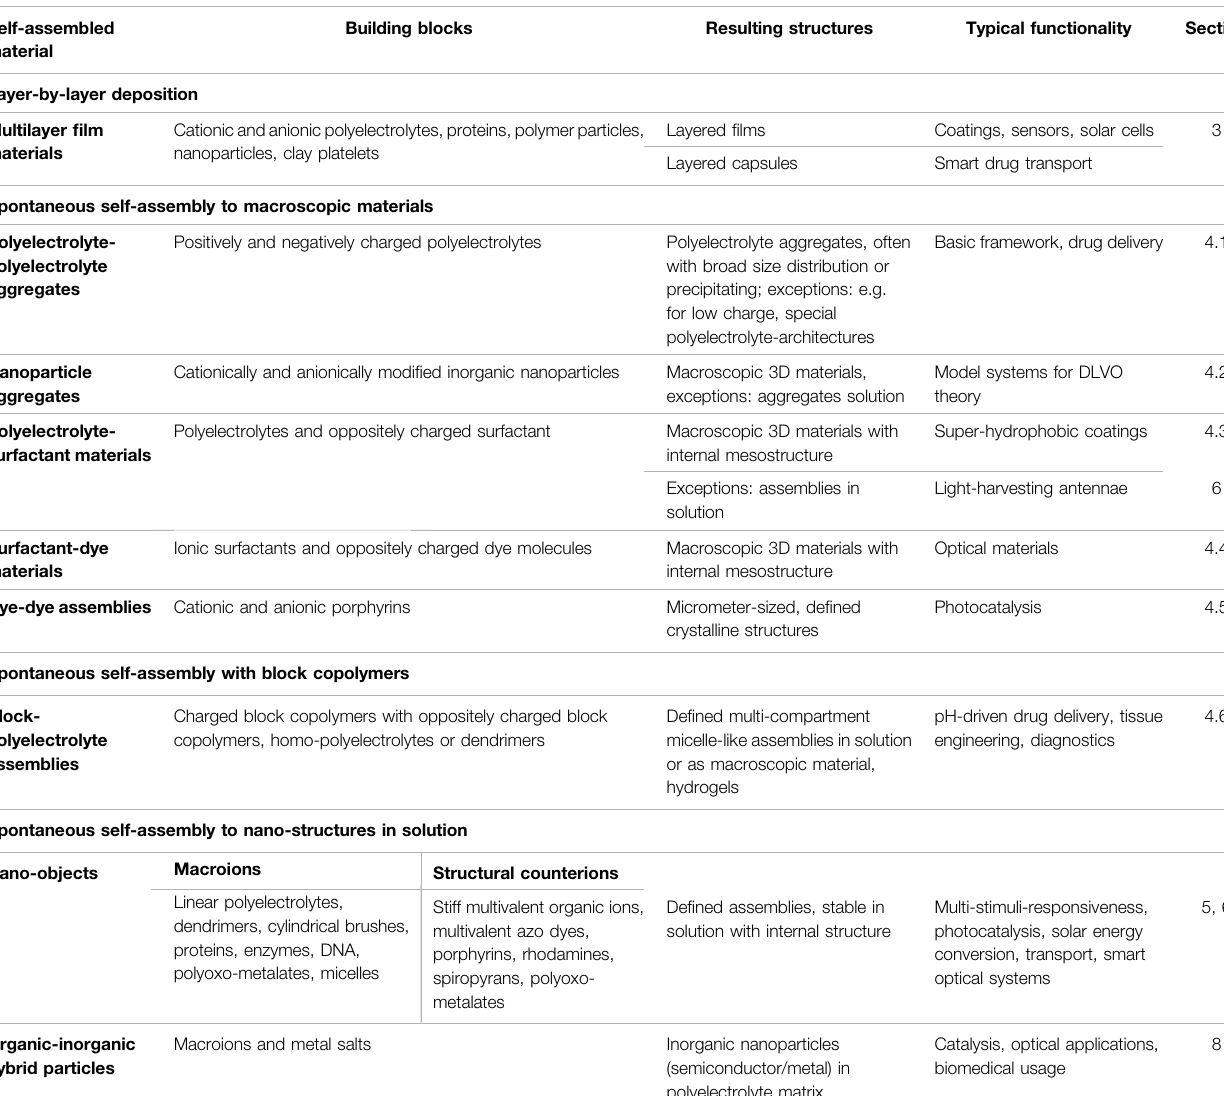
TABLE 1 | Overview of different electrostatically self-assembled